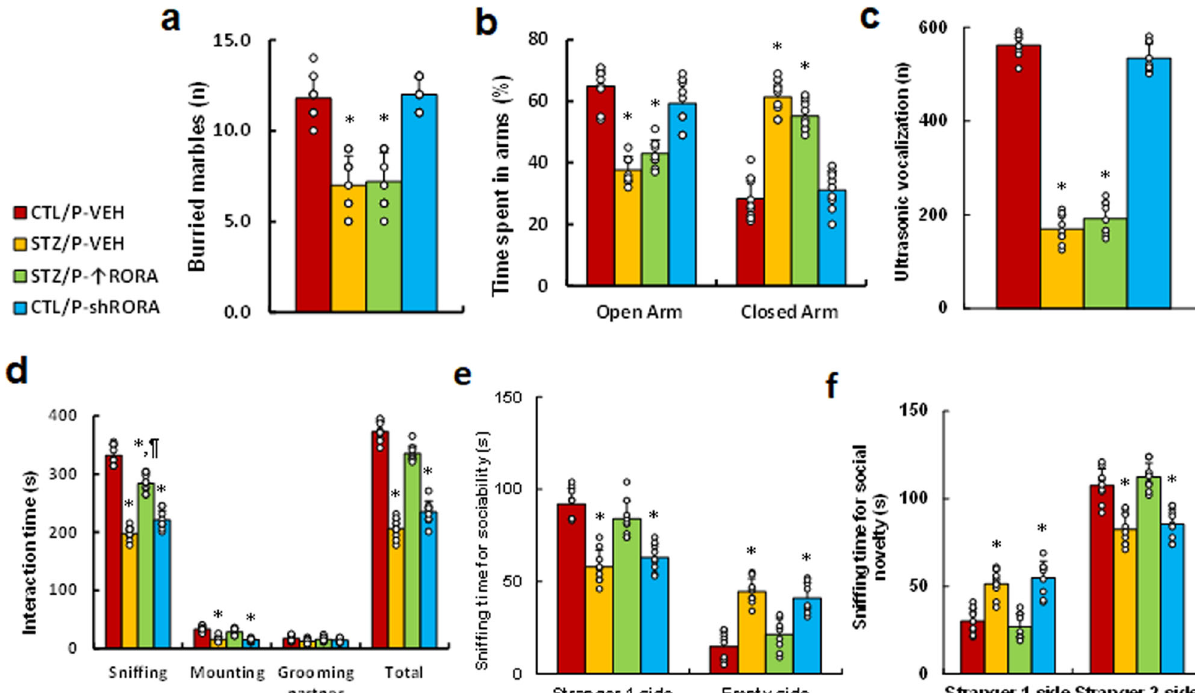
Fig. 7 Postnatal manipulation of RORA in the amygdala partly modulates maternal diabetes-induced autism-like behavior but has little effect on maternal diabetes-induced anxiety-like behavior in offspring. Male offspring from either the control (CTL) or maternal diabetes (STZ) groups received either vehicle (P-VEH) or lentivirus infusion for either RORA expression (P- ↑ RORA) or RORA knockdown (P-shRORA) at 6 weeks old, and the male offspring were used for animal behavior analysis. a Marble-burying test (MBT), n = 9. b Time spent in the Open Arm and Closed Arm in the EPM test, n = 9. c Ultrasonic vocalization, n = 9. d Social interaction (SI) test, the time spent following, mounting, grooming, and snif fi ng any body parts of the other mouse was calculated, n = 9. e , f Three-chambered social tests, n = 9. e Time spent in the chamber for sociability. f Time spent in the chamber for